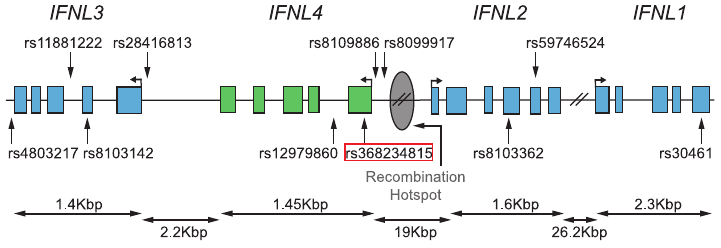
Figure 4. Map of the IFNL locus with locations of relevant SNPs (from Table 2) and the inferred recombination hotspot based on recombination rates from